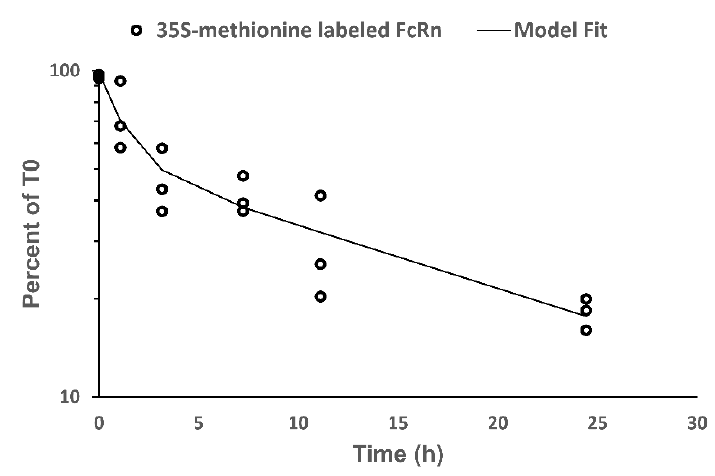
Figure 6. Degradation of 35S-methionine labeled FcRn in EA.hy926 cells. Decline in 35S-methionine labeled FcRn with time is expressed as a percent of labeled FcRn at 0 h. Each data point represents cells collected from a single T-flask. The fitting of a bi-exponential model to the data is shown by a solid line. Table 4. Fitted model parameters.